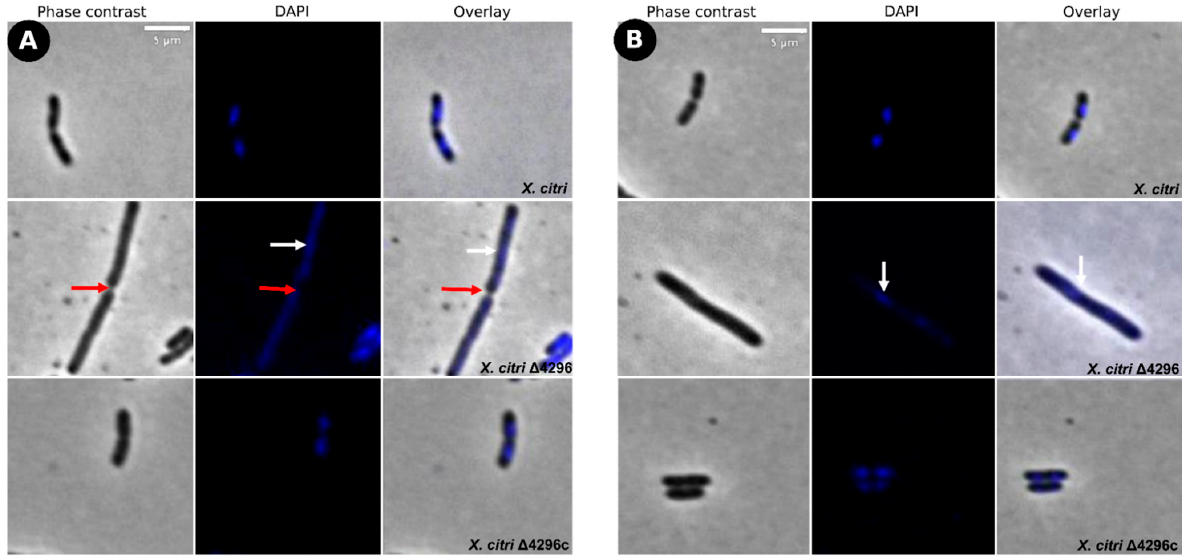
Figure 5. Short filaments and chain phenotype show partial reversion in sucrose’s presence as carbon source ( A ) Morphological analysis of X. citri , Δ 4296, and Δ 4296c strains on NB supplemented with sucrose 0.1% ( w / v ). ( B ) NB supplemented with sucrose 0.1% ( w / v ) and ampicillin 20 µg/mL. The figure shows the phase contrast, DAPI, and overlay of the two filters for X. citri ; Δ 4296 and Δ 4296c. White arrows indicate the chromosome distribution, and red arrows indicate septum constriction (magnification of 100×)—scale = 5 µm.